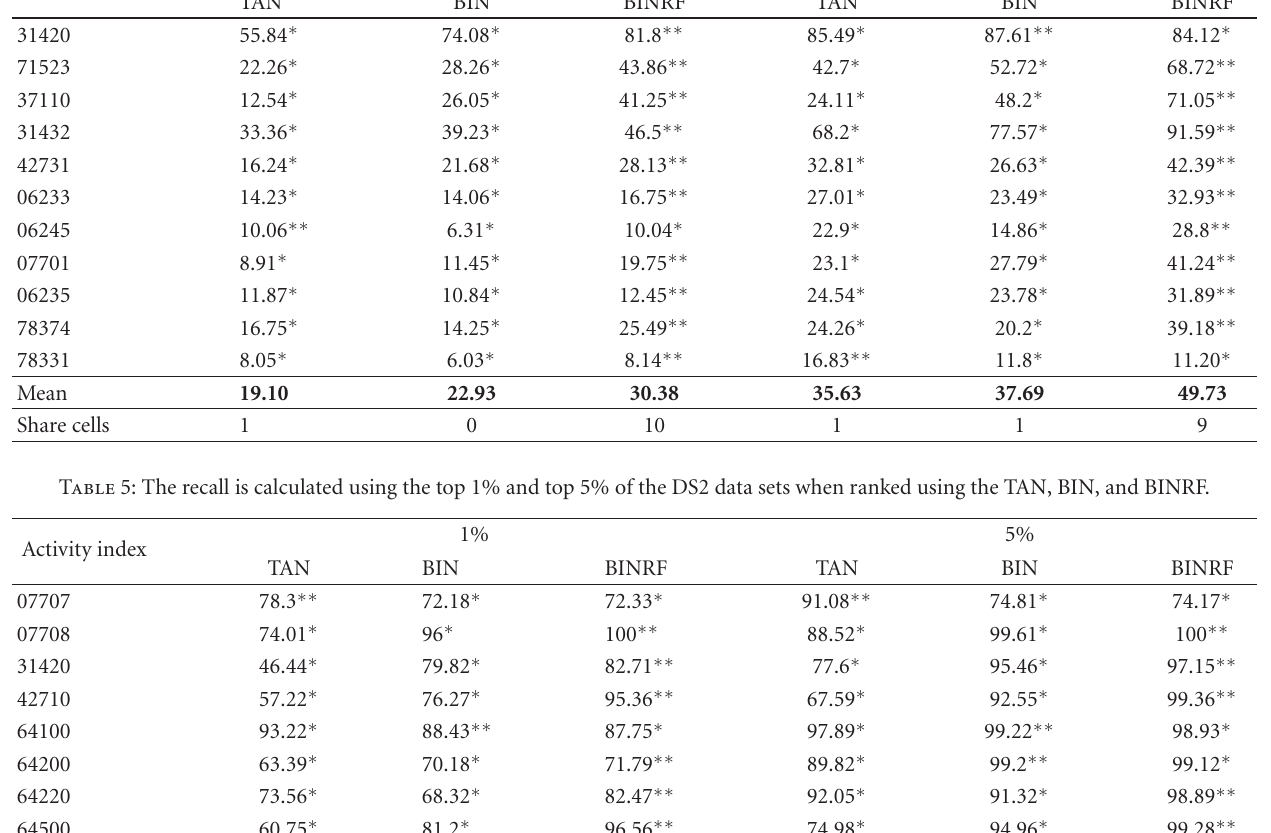
Table 4: The recall is calculated using the top 1% and top 5% of the DS1 data sets when ranked using the TAN, BIN, and BINRF. Activity index